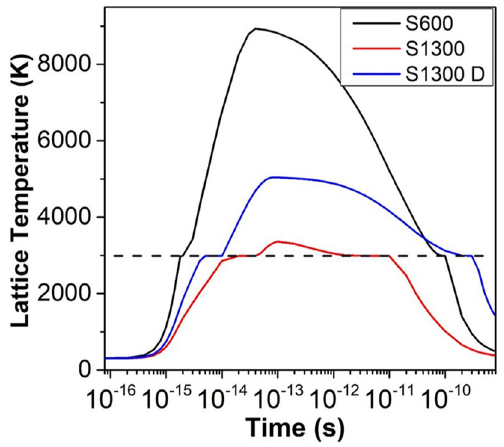
Figure 4. Variation in lattice temperature with time at the center of the ion track for pristine S600, pristine S1300 and S